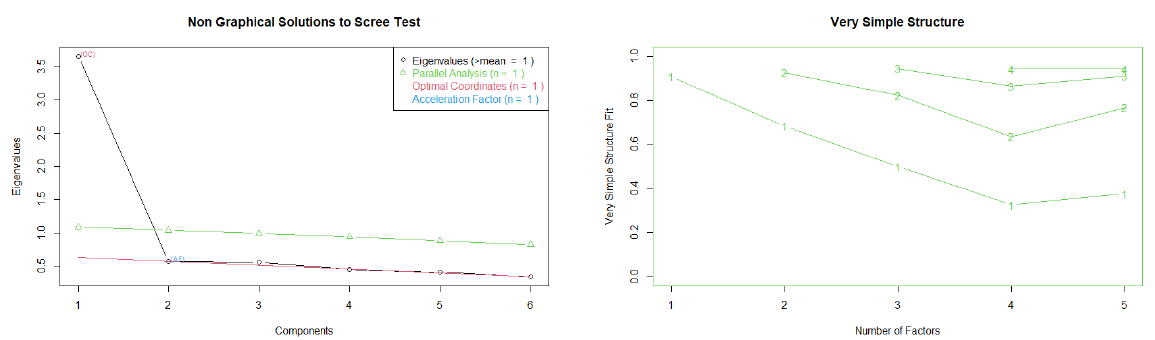
Figure 3. Graphical representation of uni- or multidimensional solutions using PA, OC, AF (on the left ) and VSS (on the right ).